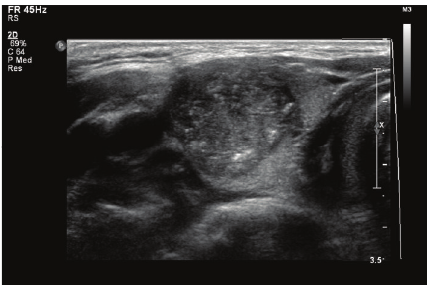
Figure 2: Thyroid ultrasonography of an 18-year-old girl with Hashimoto’s thyroiditis. An oval poorly defined hypoechoic solid nodule containing internal microcalcifications which is 2.7 cm in diameter is evident in the right thyroid